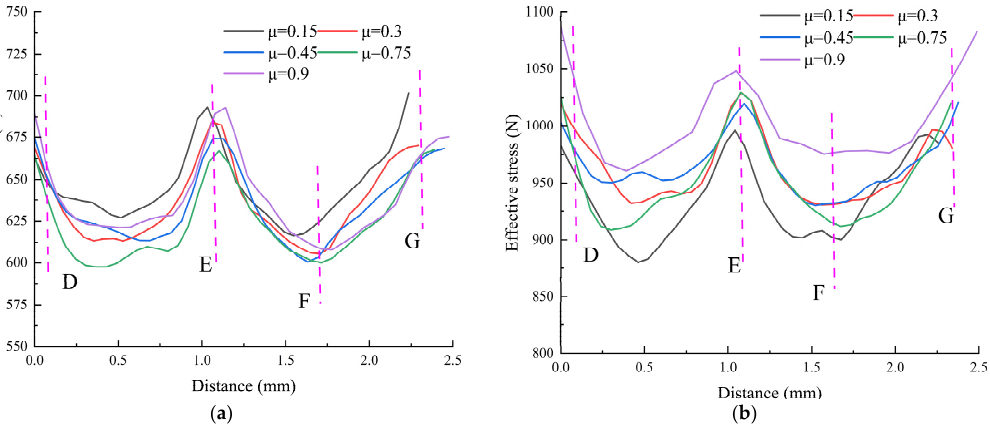
Figure 17. Variation curves of effective stress of the fins along trajectory DEFG direction under different conditions: ( a ): RT-EM; ( b ): CT-EM.